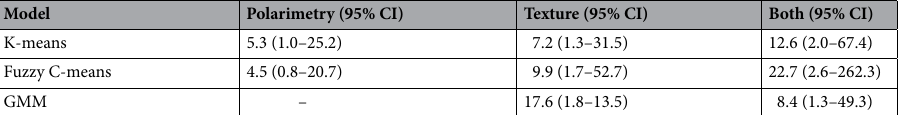
Table 2. Contributions of the polarimetric and of the texture features to the cluster—survivor association, quantified via an odds ratio (OR), using the features-average approach. As seen, the use of both types of features seems to improve discrimination (note that for GMM, polarimetry-only OR could not be calculated due to zero survivors in Cluster 2 (results not shown)).